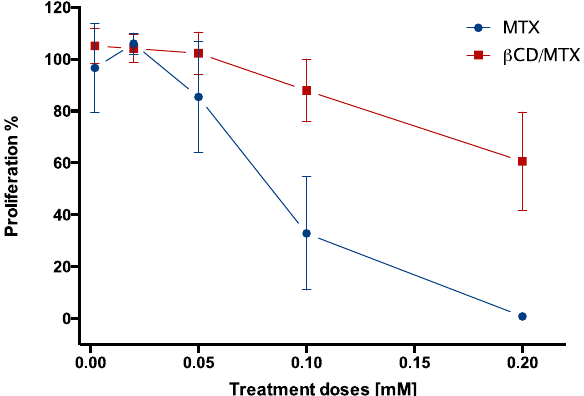
Figure 9. Comparison of cell viability of the HeLa cells treated with MTX or β -CD/MTX at different MTX concentrations (0.002–0.2 mM). The data are expressed as percentages of the live cells relative to the untreated cells (controls). The values represent the mean and SEM of three separate experiments in triplicate (* p < 0.05).